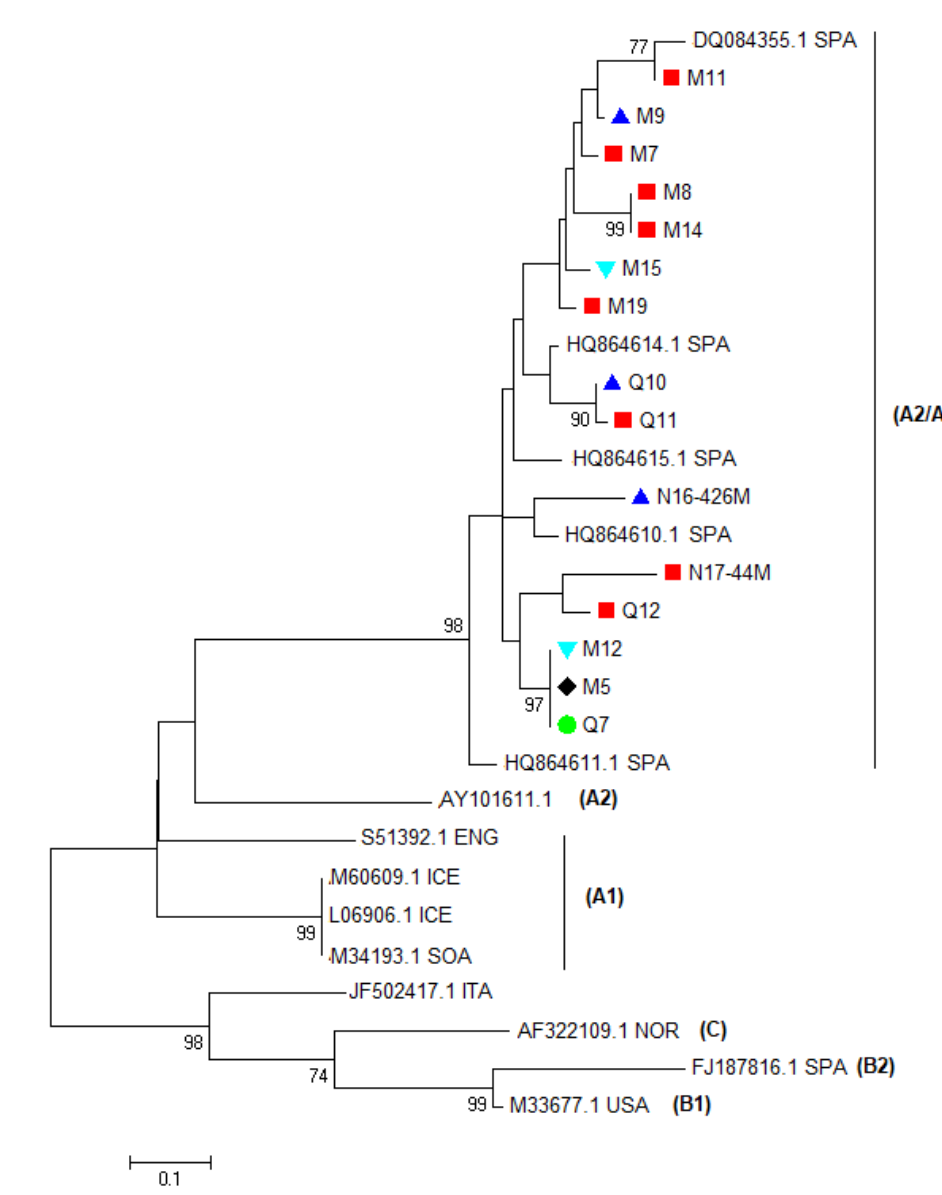
Figure 5. Phylogenetic analysis of the SRLV partial LTR. Sequences of different SRLV genotypes and subtypes available in GenBank were used as reference isolates. Reference sequences are indicated with their accession number and country of origin (CAN: Canada; CHI: China; ENG: England; ICE: Iceland; ITA: Italy; MEX: Mexico; NOR: Norway; POR: Portugal; SOA: South Africa; SPA: Spain; SWI: Switzerland; USA). Samples are indicated with their codes and are labeled on the basis of the score of the mammary lesions observed ( ▲ severe, ■ moderate, ▼ minimal, ● no lesions, ♦ not available). The phylogenetic analysis was performed with a maximum likelihood (ML) method using the Kimura 2-parameter model with a gamma distribution and with bootstrap values based on 1000 repetitions. Sequences are not deposited in GenBank because they do not reach the minimum length required.